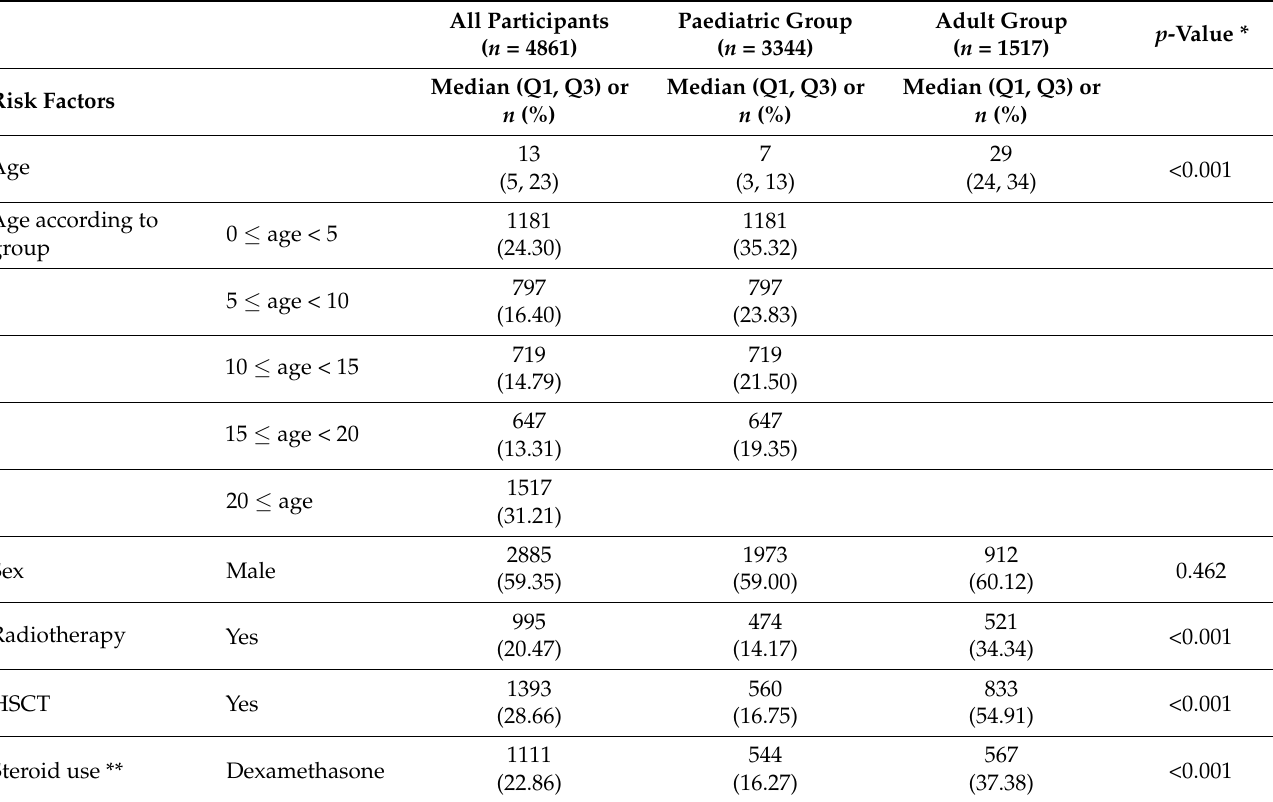
Table 1. Demographic characteristics of all the